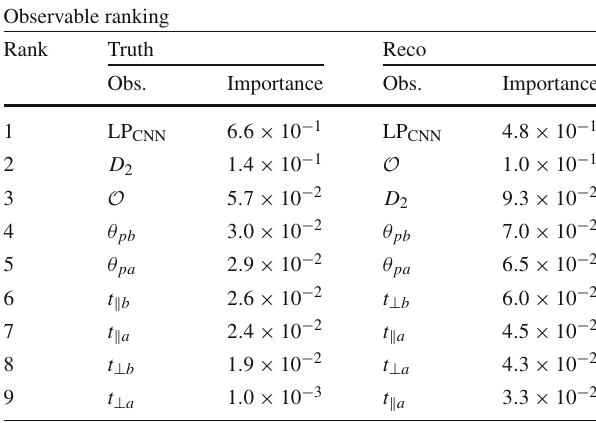
Table 3 BDT observable ranking for the truth and reco cases Observable